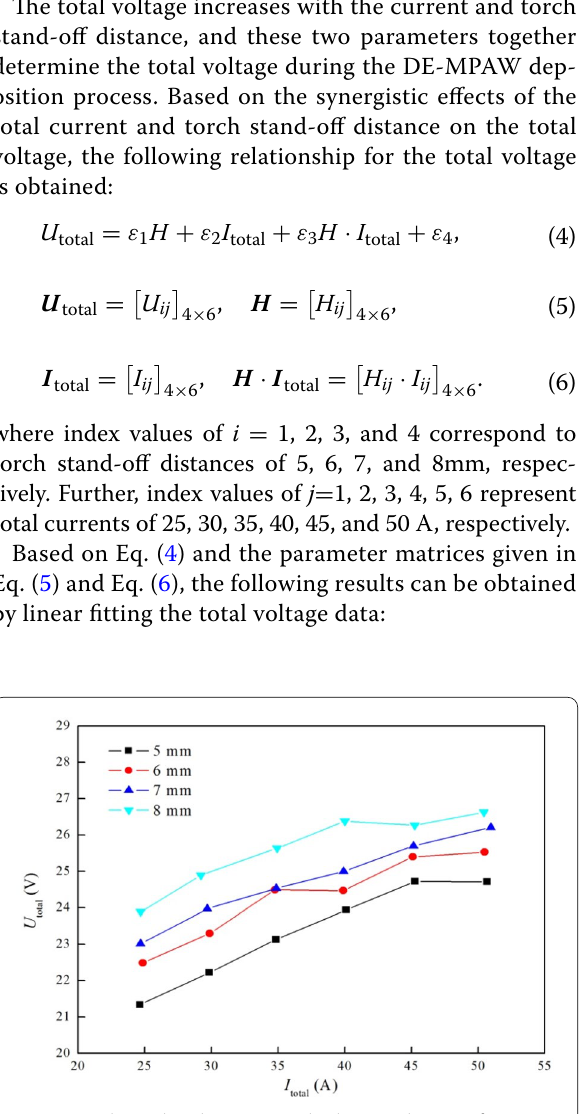
Figure 4 Relationships between total voltage and current for different torch stand-off